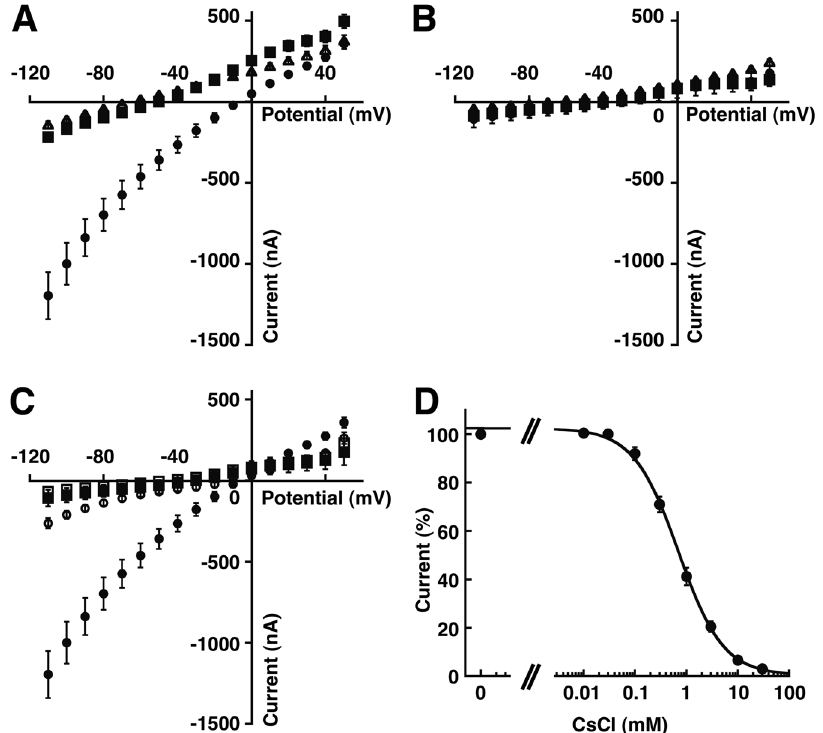
Figure 3. Current-voltage relationship. ( A ) Current-voltage relationship of TbIRK expressing oocytes in sodium medium (squares), potassium medium (circles) and N -methyl- D -glucamine medium (open triangels) (mean ± S.D.; n = 31 for sodium and potassium medium and n = 23 for N -methyl- D -glucamine medium). ( B ) The corresponding I/V relationship of water-injected oocytes in sodium medium (squares), potassium medium (circles) and N -methyl- D -glucamine medium (open triangels) (mean ± S.D.; n = 25 for sodium and potassium medium and n = 19 for N -methyl- D -glucamine medium). ( C ) Comparison of the I/V relationship of TbIRK expressing oocytes in potassium medium (circles) or sodium medium (squares) in presence (open symbols) or absence (closed symbols) of 10 mM CsCl (mean ± S.D.; n = 31 and 16, respectively for TbIRK-expressing oocytes and n = 25 an 14, respectively for water-injected control oocytes). ( D ) Inhibition by caesium was determined by changing from sodium medium to potassium medium containing different CsCl concentrations at − 80 mV. The observed currents normalized to the response elicited by potassium medium in the absence of caesium. The inhibition curve was fitted with an IC 50 of 0.74 ± 0.11 mM (mean ± S.E.M.; n =